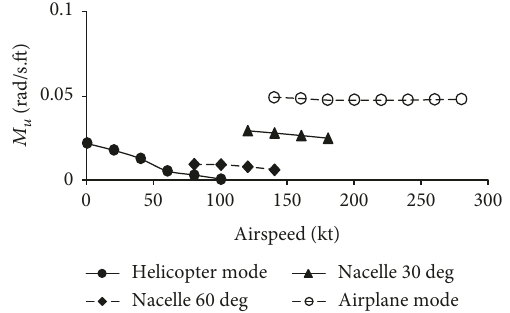
Figure 14: Variation of the derivative L